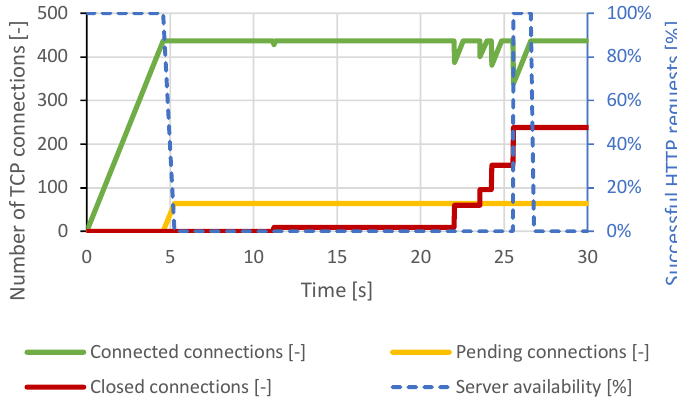
Figure 4. Slow POST attack against Apache server.